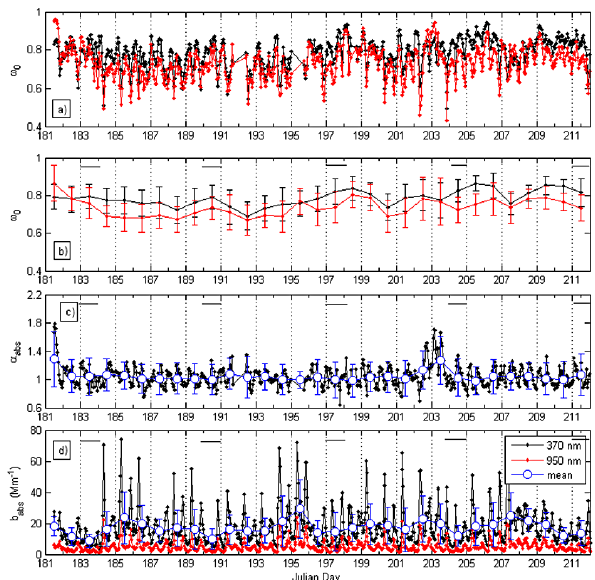
Figure 5. Temporal evolution of: (a) ω 0 , 370 and ω 0 , 950 hourly av- eraged, (b) ω 0 , 370 and ω 0 , 950 daily averaged, (c) α abs hourly (black line) and daily averaged (blue dots), and (d) b abs , 370 and b abs , 950 hourly averaged and daily averaged values for b abs , 370 (blue dots) with their standard deviations. Black lines correspond to hourly av- erages at 370nm and red lines to hourly averages at 950 nm, except for α abs and panel (b) , where they correspond to daily averages. All these data correspond to the period June–July 2012.